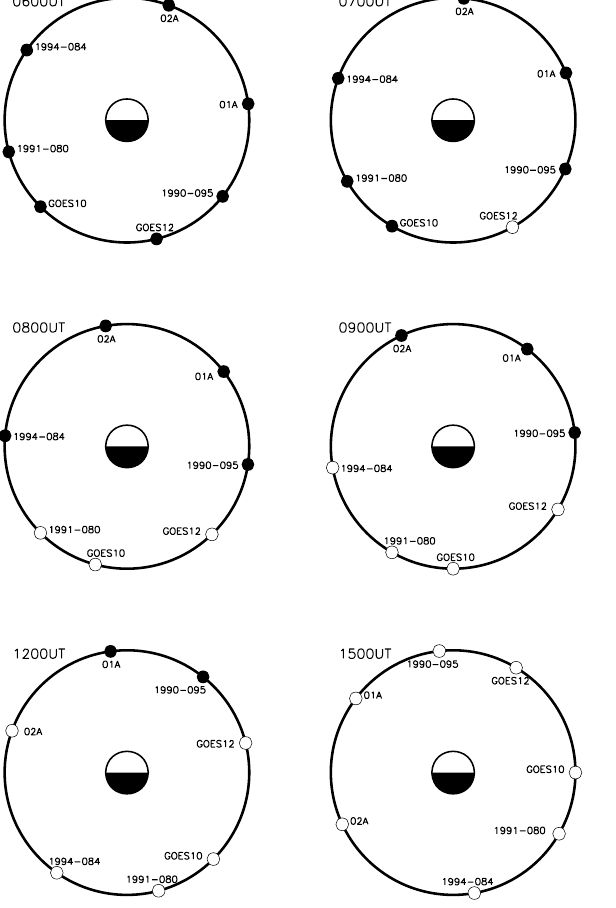
Fig. 2. Local time progression of electron flux dropouts observed by seven geosynchronous spacecraft. Black circles indicate high level flux, while open circles shows electron flux dropouts.